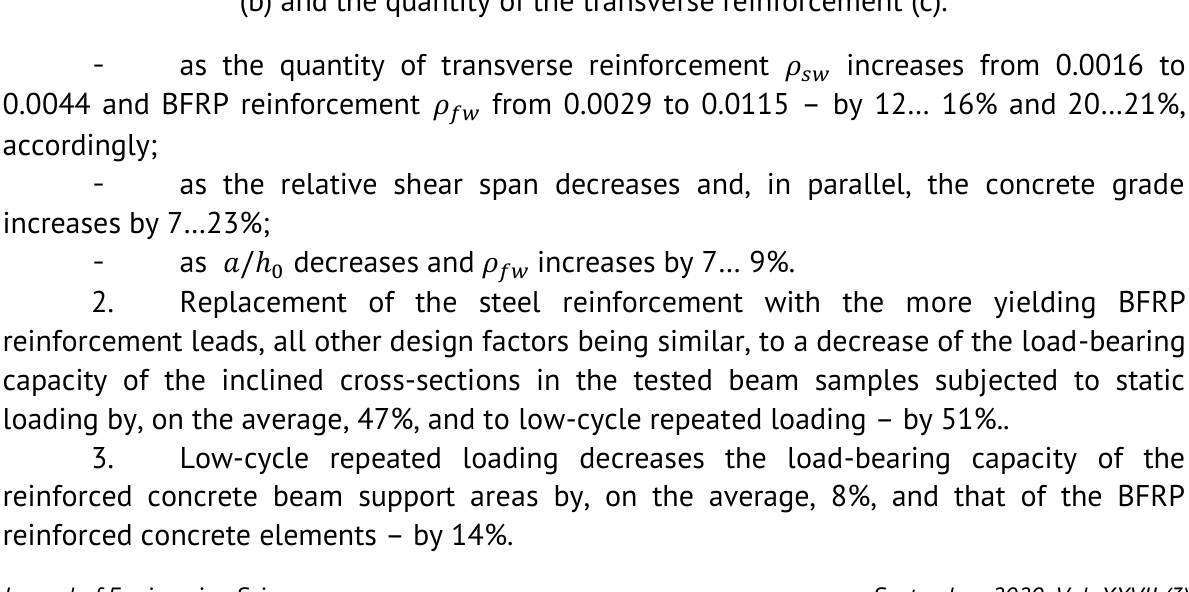
Figure 6. Opening width of the inclined cracks in the test beam samples subjected to the operational load level versus the relative shear span value (a), concrete grade (b) and the quantity of the transverse reinforcement